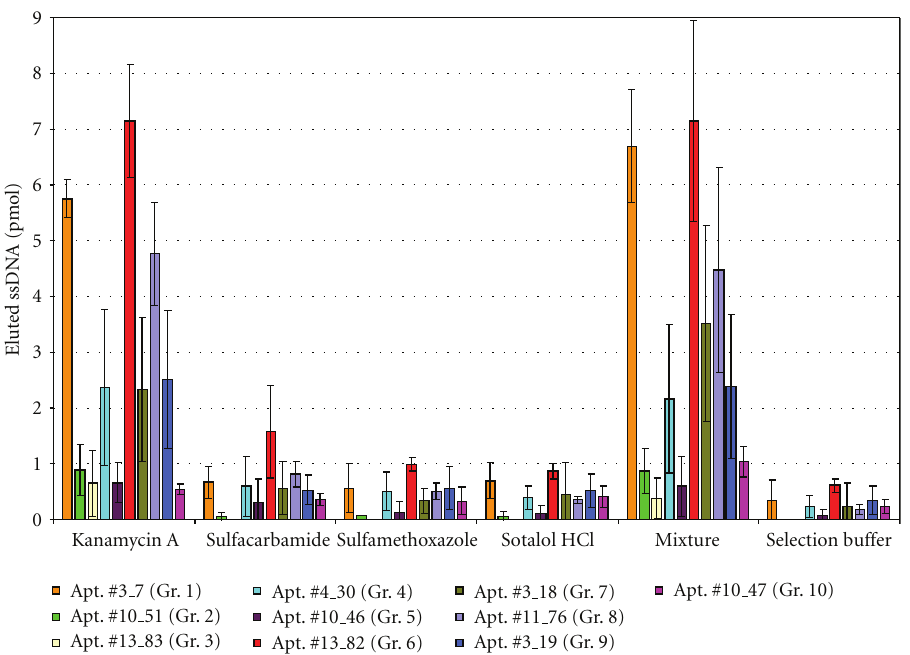
Figure 5: Specificity tests on the representative of each of the groups of DNA oligonucleotides derived from Capture-SELEX against the mixture of pharmaceuticals. Conditions were chosen comparably to the steps in the SELEX procedure. The four pharmaceuticals were tested individually at a concentration of 1mM in selection bu ff er as well as their mixture and selection bu ff er alone as a negative control. The amount of eluted ssDNA was normalized to 5 × 10 7 beads. Experiments were performed in duplicate or triplicate in the case of binding sequences (aptamers), the representatives of groups 1, 4, 6, 7, 8, and